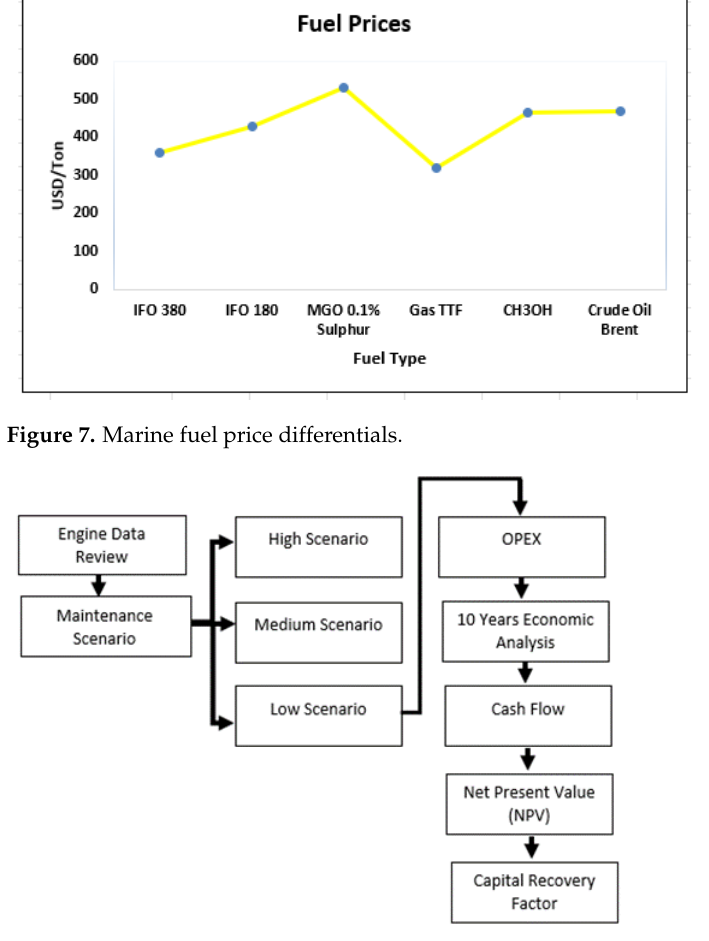
Figure 8. Flow Diagram for data analysis.